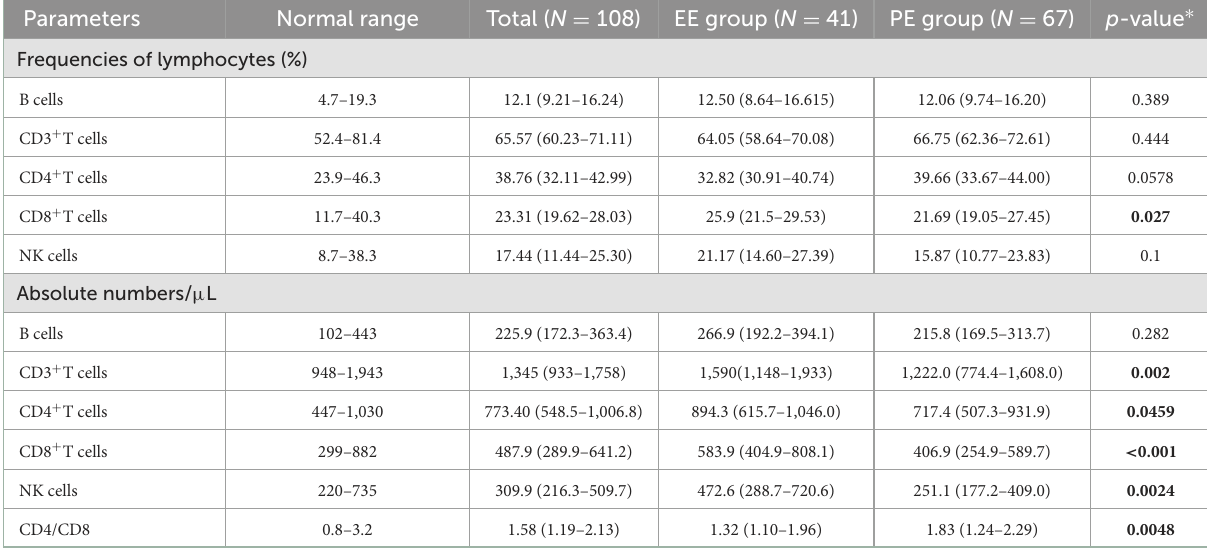
TABLE 4 Relative frequencies and absolute numbers lymphocyte subpopulations in periphery blood of COVID-19 patients.